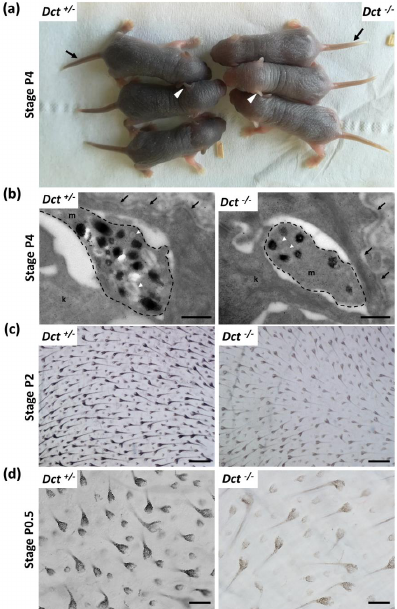
Figure 2. Melanization of the skin and hair in newborn Dct − / − mice. ( a ) Dct − / − pups can be easily distinguished from Dct +/ − littermates at P4 when their skin and first hair are visibly lighter. The tail (black arrow) and the outer ear (white arrowheads) are unpigmented in Dct − / − pups at this stage, whereas the tail and ears of control littermates are dark; ( b ) ultrastructure of epidermal melanocytic extensions (marked out with a dashed line) in the skin of P4 mice, showing that Dct − / − skin has fewer stage III/IV melanosomes than controls. Most pigmented melanosomes have irregular borders in Dct − / − epidermis. k, keratinocyte; m, melanocyte; the dermis-epidermis junction is indicated by arrows. Early unpigmented melanosomes are indicated by white arrowheads; scale bar: 500 nm; ( c ) bright-field microscopy imaging of flat-mounted skin biopsies at P2 showing pigmentation of the first hair follicles at the inner face (for quantification, see Figure S1); scale bar: 250 µ m; ( d ) same imaging as at P0.5 when only 50% of hair follicles are visibly pigmented in Dct − / − pups; note that the hypodermis is lighter in Dct − / − samples; scale bar: 100 µ